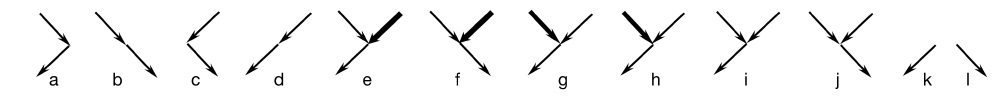
Figure 1. All possible water-flow cases being able to appear by this stochastic model. The bolder line indicates that the drainage area at that site is larger than that of the other site represented with normal lines. When the position of a center is ( x , y ) , the dynamical replication probabilities for several cases are as follows: for a, α [ a ] = 1 − a − δ ( x − 1, y − 1 ) , for e, α [ a ] = 1 − ( a ( x + 1, y − 1 ) − a ( x − 1, y − 1 )) − δ , and for from i to l, α [ a ] =